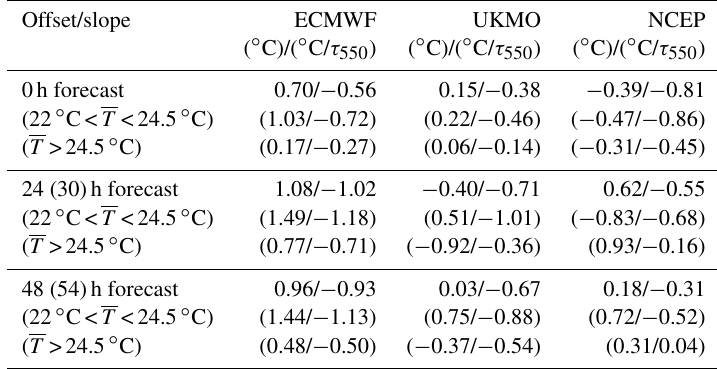
Table 4. Offsets ( ◦ C) and slopes ( ◦ C/ τ 550 ) of MODIS τ 550 vs. the differences between observed (using ground stations as shown in Fig. 7c) and modeled near-surface air temperatures (at 18:00UTC, 29 June 2015) from ECMWF, UKMO, and NCEP model runs. Similar results using only stations with monthly mean temperatures ( T ) within the range of 22 to 24.5 ◦ C, as well as for stations with T >24.5 ◦ C are also shown.